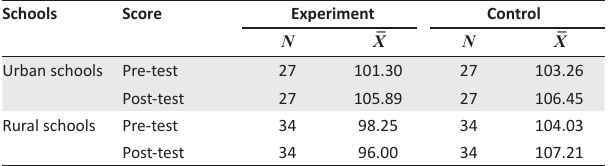
TABLE 2: Disaster awareness score data.